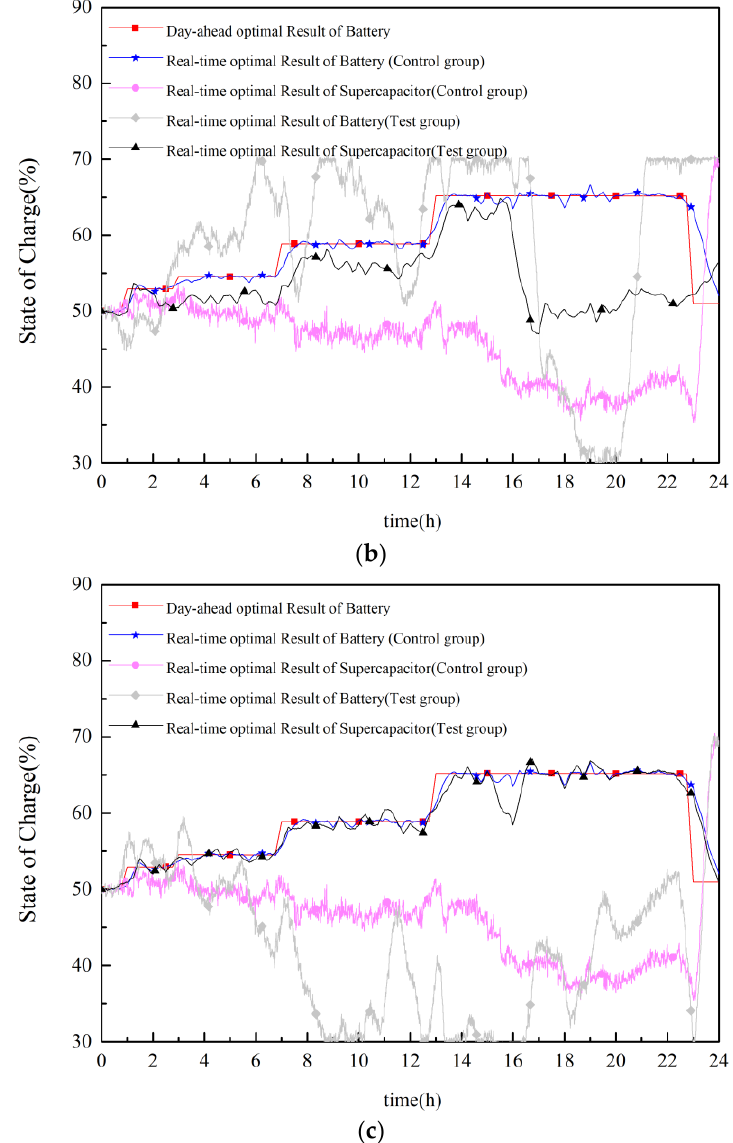
Figure 8. SOC waveforms of the HESS. ( a ) Ignore the SOC error regularization in intraday rolling. ( b ) Adjust ETESS with high priority in quasi-real-time coordinated control and does not use comprehensive criteria. ( c ) Adjust DSGs with high priority in quasi-real-time coordinated control and does not use comprehensive criteria.